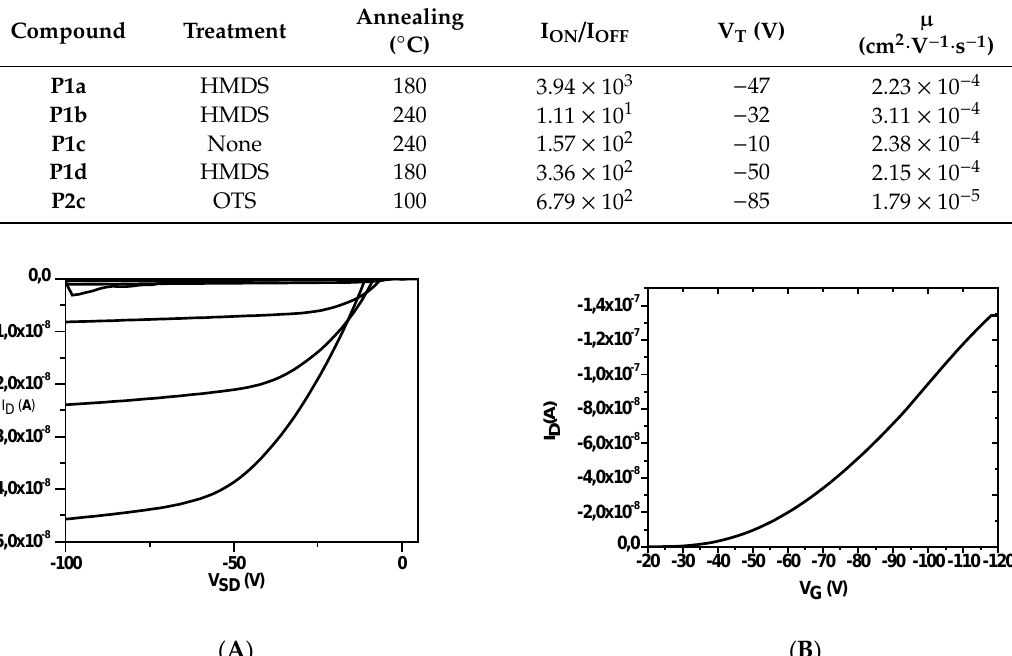
Figure 6. Output ( A ) and transfer ( B ) plots for P1a . V G varies from 20 to − 100 V (in 20 V steps). Table 4. Summary of the organic field-effect transistors (OFET) parameters for the studied polymers.